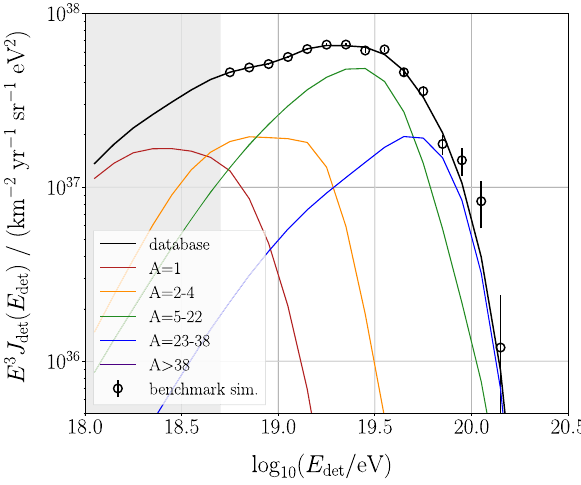
Fig. 2 Observed energy spectrum at Earth after injection following Fig. 1. As symbols with Poissonian errors, the benchmark simulation spectrum with O ( 70 , 000 ) events is shown, with different colors for the different detected element groups. The curves depict the prediction by thepropagationdatabasescaledtothesamenumberofcosmicrays.The gray area marks the part of the energy spectrum below the threshold at 10 18 . 7 eV, which is not part of the fit